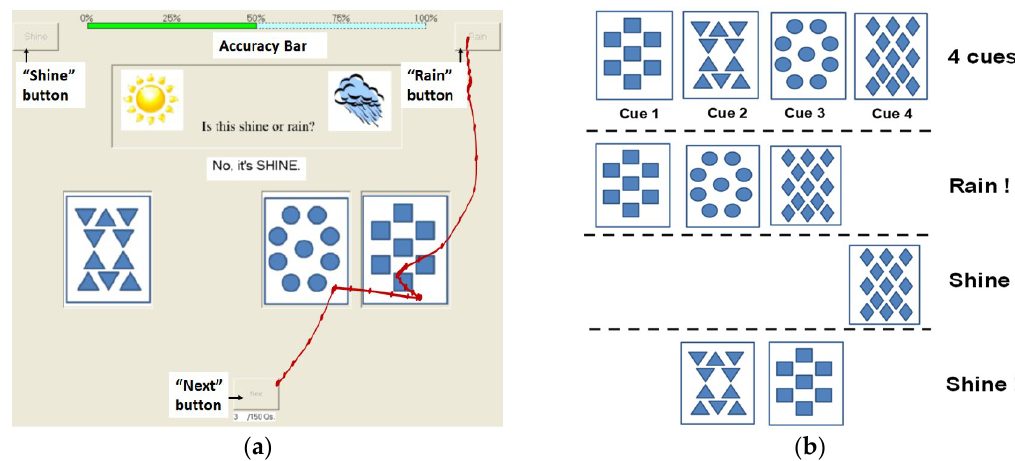
Figure 1. ( a ) A screen shot of a concept learning trial. The red line, which was not shown in the actual experiment, illustrates a trajectory of the computer cursor. In each trial, a new card combination appears as the participant clicks the “Next” button and the participant judges whether the combination is “shine” or “rain” by clicking the “Shine” or “Rain” button placed top corners of the screen. The movement of the computer cursor is recorded from the onset of a trial (the Next button is pressed) to the end (either the Shine or Rain button is pressed). ( b ) Examples of card combinations. To start a trial, the participant first pressed the Next button, the cursor was then placed automatically at the center of the button, and the stimulus picture (card combination) was presented on the monitor (Figure 1). To indicate a selection, participants pressed a target button (either the left or right button shown at the top left/right corner of the screen). Soon after pressing the target button, the stimulus disappeared and feedback was presented (e.g., “Yes. It’s shine”). This cycle was repeated